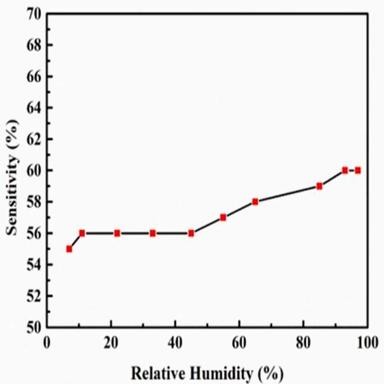
The % RH dependent variations of Sensitivity of sample ZnFe(2-x)LuxO4 where x = 0.01(Lu 0.01), 0.03(Lu 0.03), 0.05(Lu 0.05), 0.07(Lu 0.07).